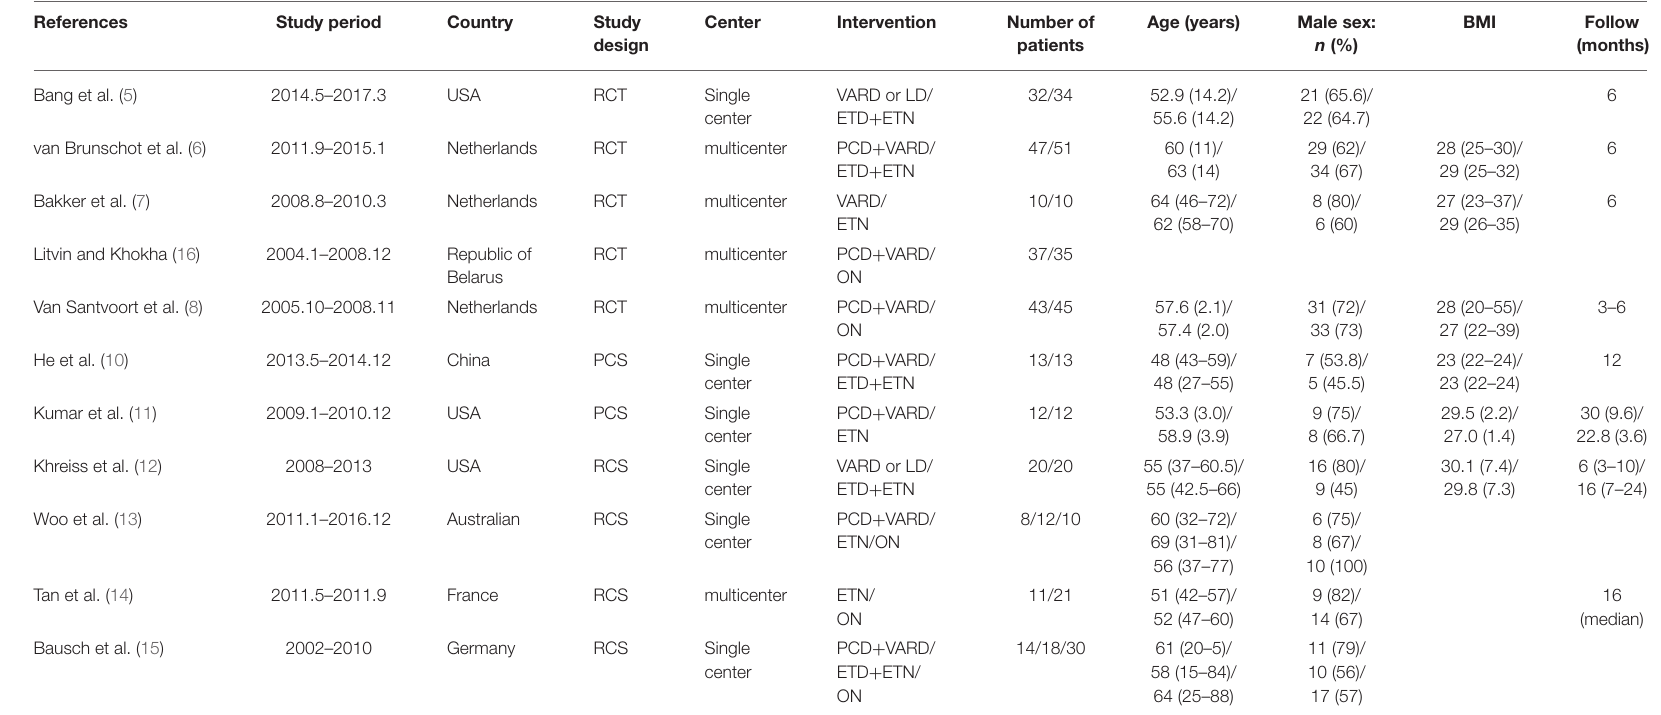
TABLE 1 | Baseline characteristics of included